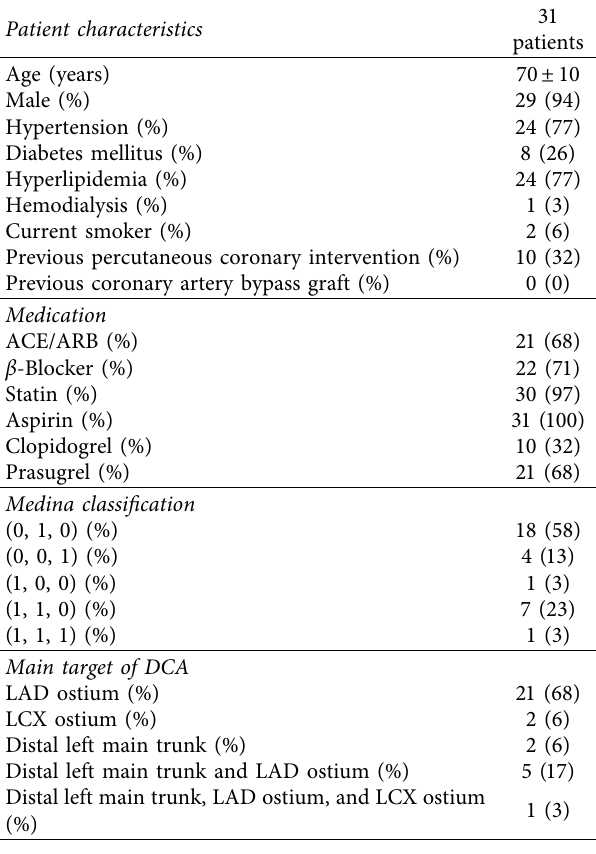
Table 1: Baseline characteristics of participants.